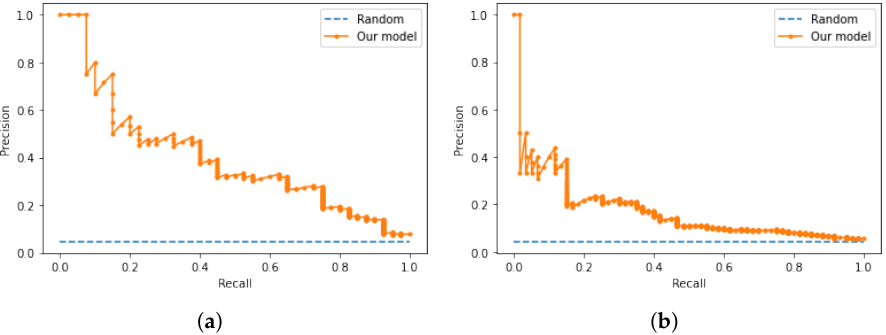
Figure 3. PR curves for the model presented in the article for the validation dataset. ( a ) 24 h ahead prediction, ( b ) 48 h ahead prediction.